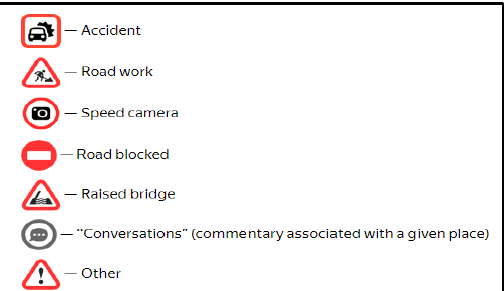
Figure 12. Road warning icons related to traffic events that can be added by